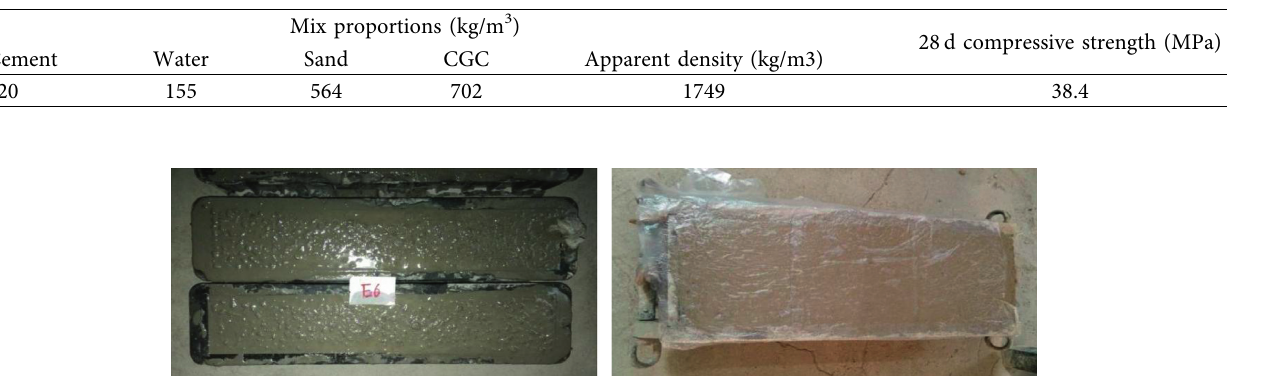
Figure 2: Forming a concrete specimen.